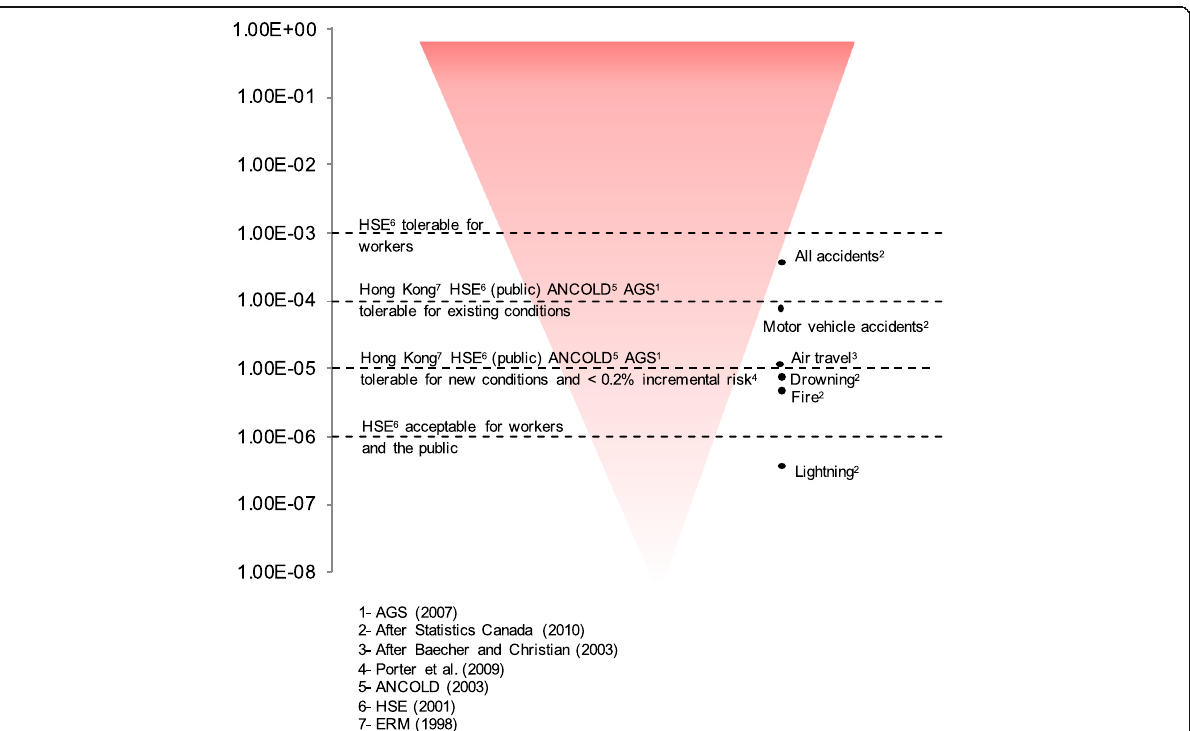
Fig. 4 Individual risk evaluation criteria (as annual probability) commonly cited in the geotechnical literature and common risks in North America. AGS (2007); Statistics Canada (2010); Baecher and Christian (2003); Porter et al. (2009); ANCOLD (2003); HSE (2001); ERM